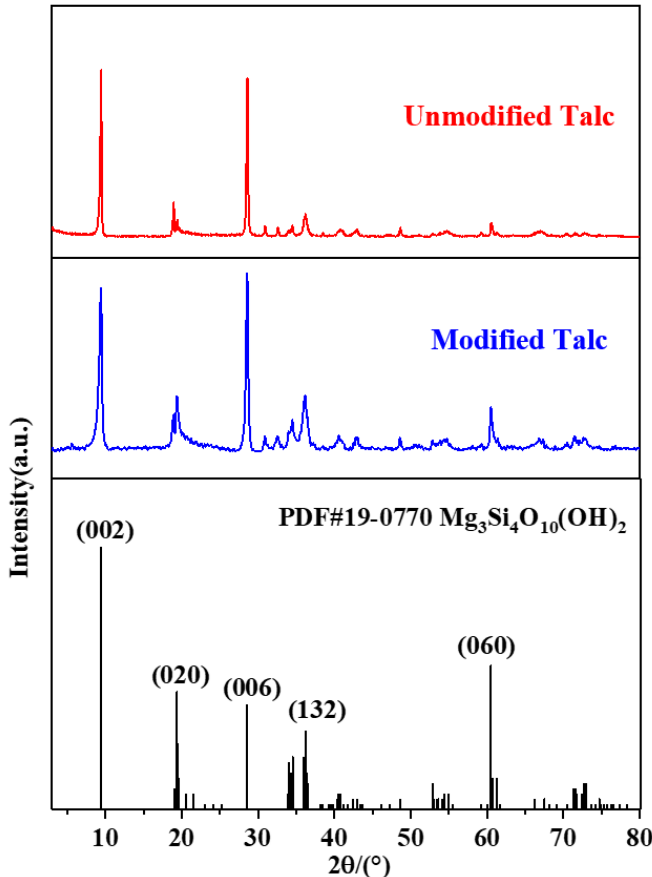
Figure 3. XRD pattern of talc nanosheets and standard spectra of the talc (Mg 3 Si 4 O 11 (OH) 2 ).